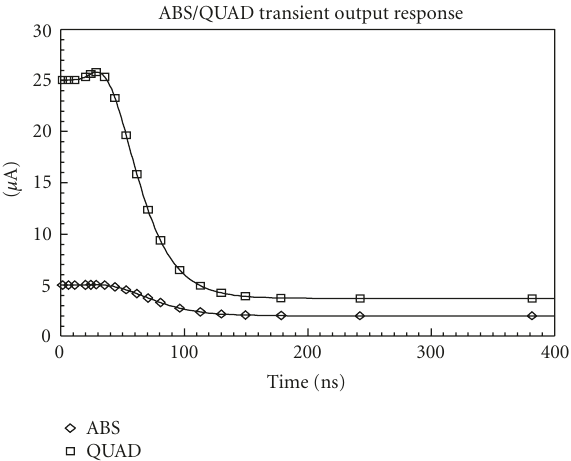
Figure 9: Transient settling of the cell output for ABS and QUAD